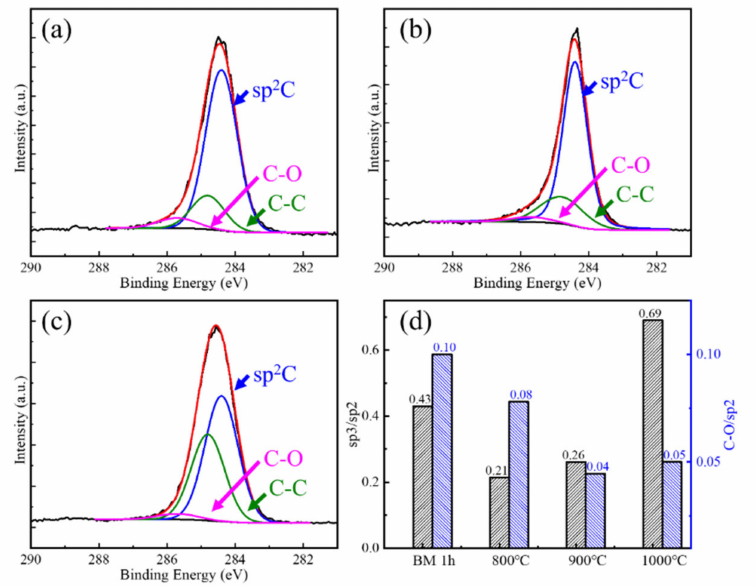
Figure 10. XPS characterization and fitting results of CVD repaired BM10h at different